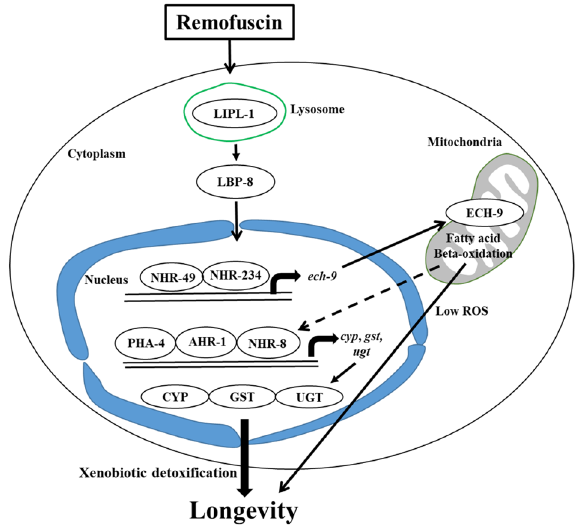
Figure 6. Predicted mechanism by which remofuscin extends the C. elegans lifespan. A lysosomal lipase, LIPL- 1, activates lipid catabolism, similar to that in a diet restriction (DR)-like state, thereby decreasing the ROS levels and subsequently activating the xenobiotic detoxification process. This sequence ultimately extends the lifespan of remofuscin-treated C. elegans . The broken line shows the predicted route based on the previously reported pathway 14